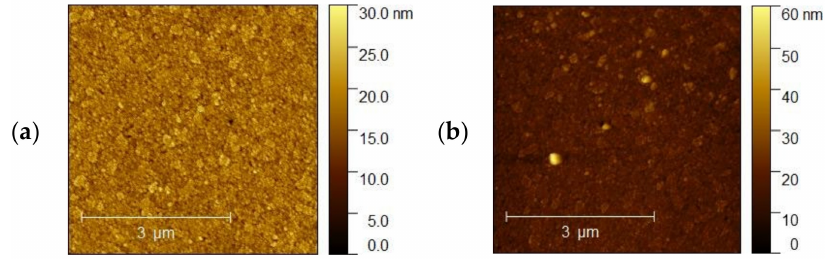
Figure 12. ( a , b ) AFM images of the ( a ) ITO3 5 nm and ( b ) ITO3 for 10